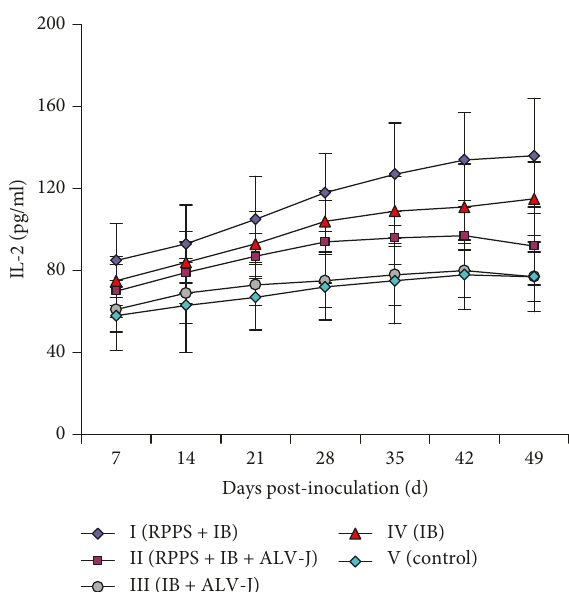
Figure 6: Changes of cytokine IL-2 level in the serum.